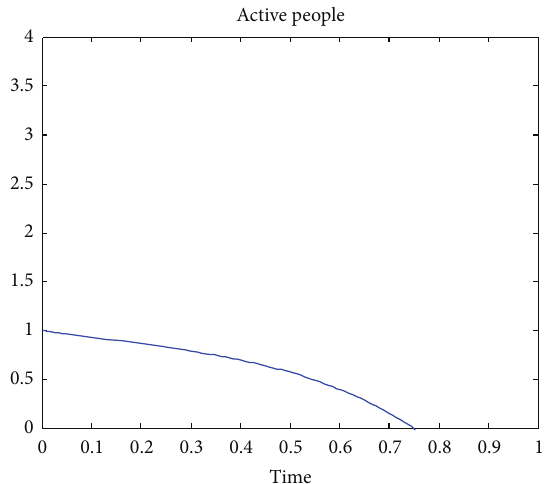
Figure 3: Approximate solution for the number of TB actively infected